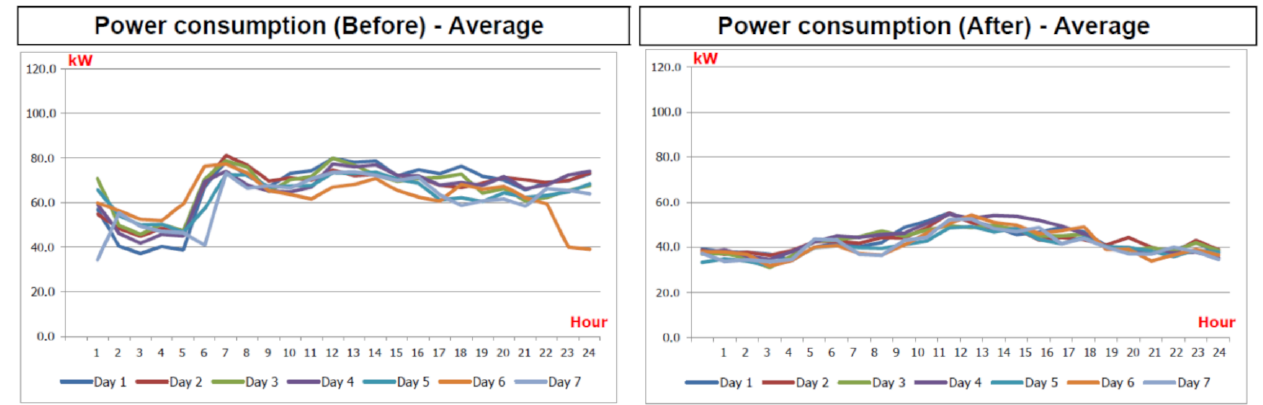
Figure 8. Average power consumption per hour before and after retrofits for store No.1 (R22).